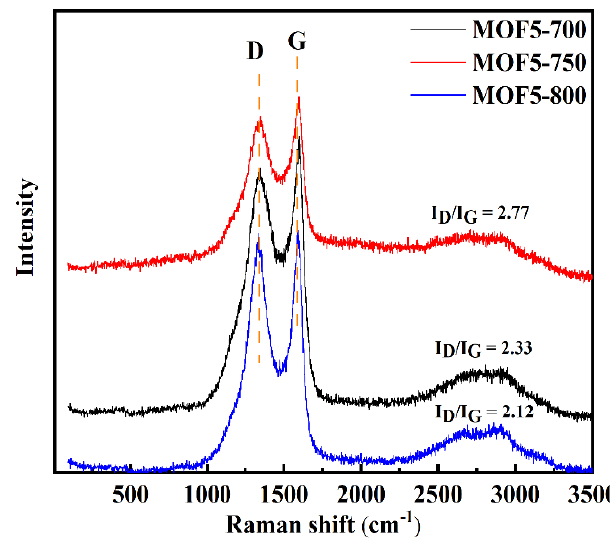
Figure 15. Raman spectra of MOF5-700, MOF5-750 and MOF5-800.